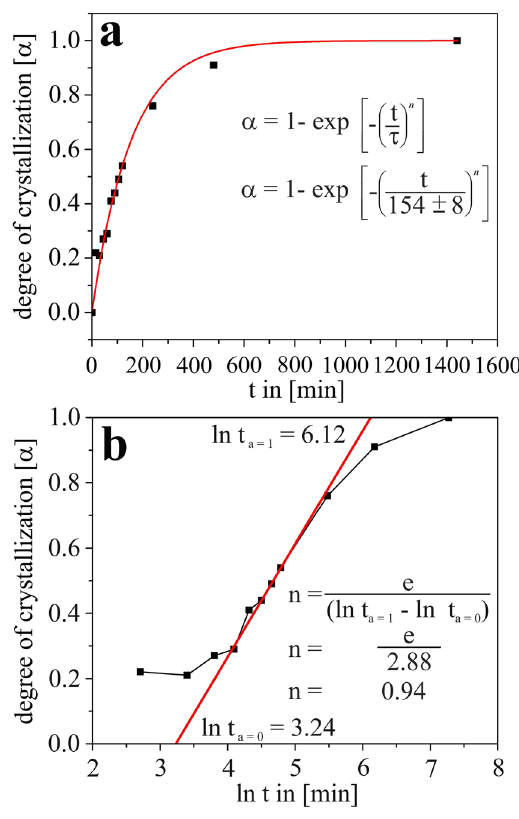
Figure 10. Degree of ZrO 2 crystallization α after different times t of at 725 °C in ( a ) linear and ( b ) logarithmic representation. From ( b ), the Avrami coefficient of n = 0.94 ≈ 1 could be determined (for details, see text). In subfigure ( a ) the fitted Avrami plot with n set to 1 is shown as